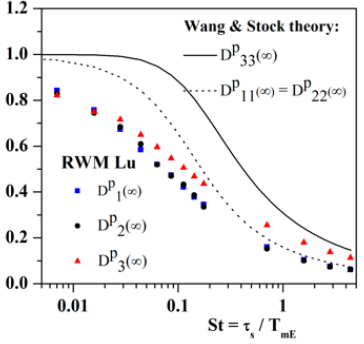
Figure 16. Particle dispersion coefficients (g ≠ 0).